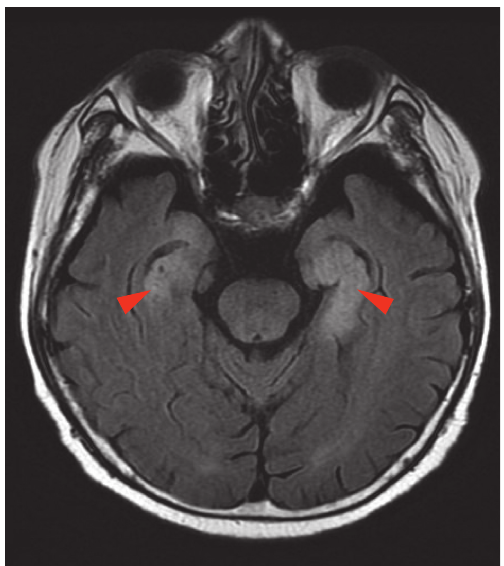
Figure 1: Fluid-attenuated inversion recovery (FLAIR) image of brain magnetic resonance imaging (MRI) before initiation of treatment with immune checkpoint inhibitor reveals no abnormal finding.